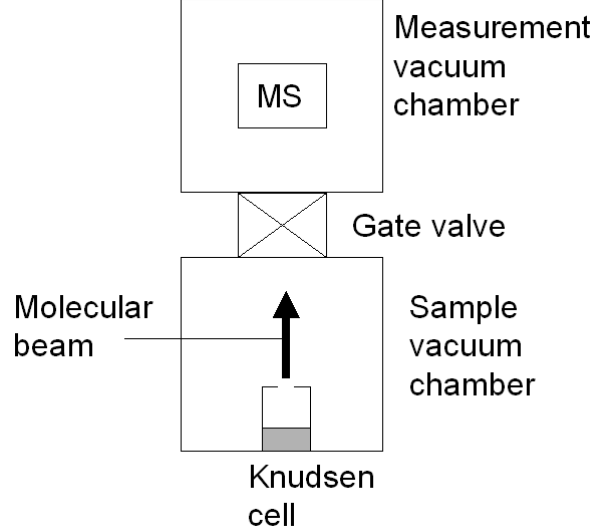
Fig. 1. Schematic of KEMS system. Reproduced from Booth et al.